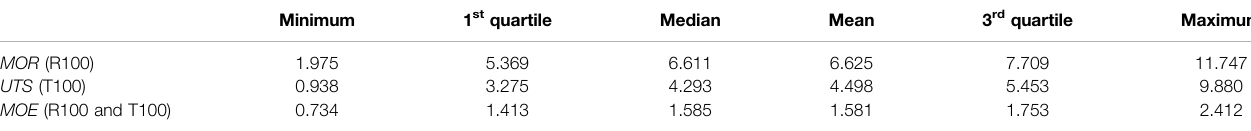
TABLE 1 | Summary statistics for MOR , UTS , and MOE based on the R100 and T100